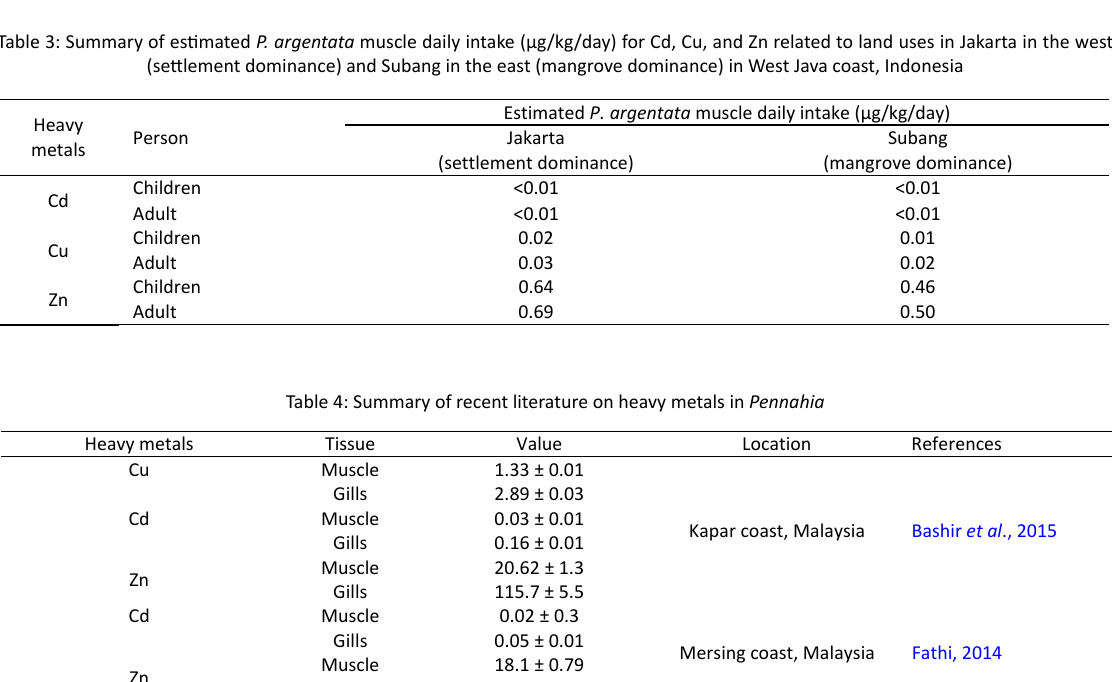
Physico‐chemical parameters